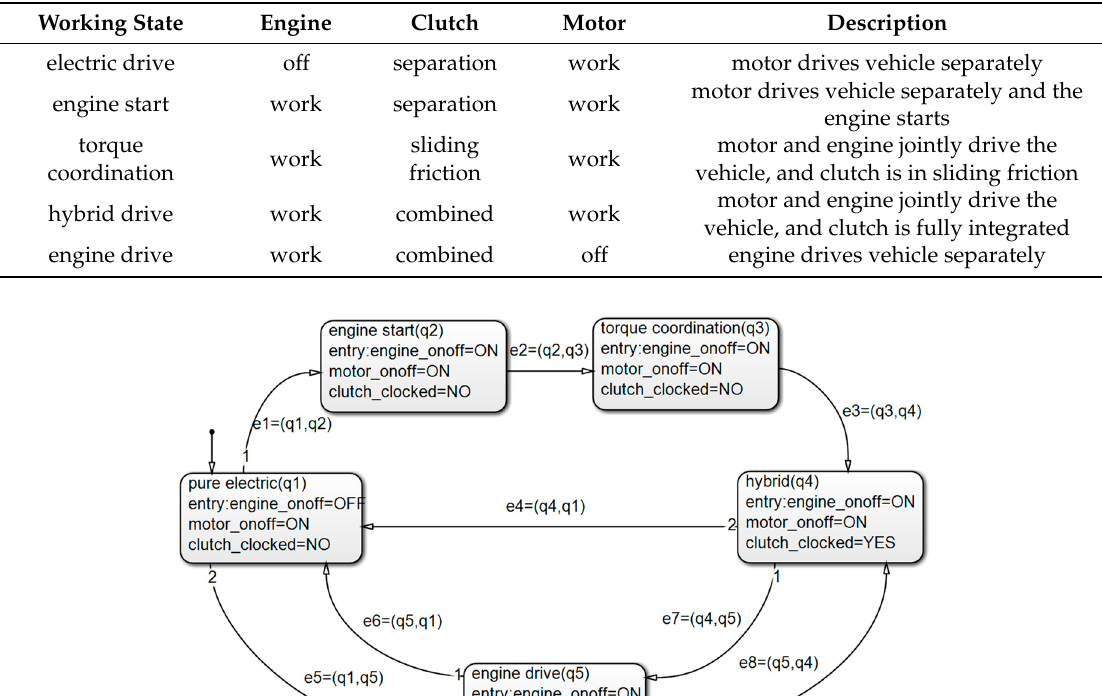
Table 1. States of the operating mode.